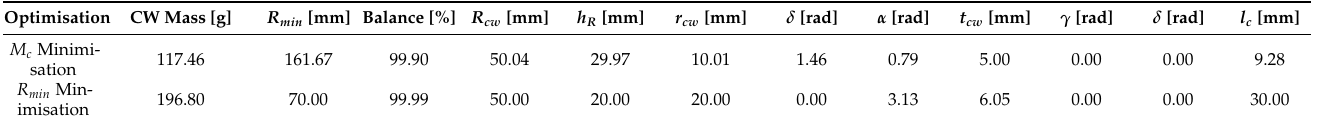
Table 3. Results for two optimisations of the counterweights.